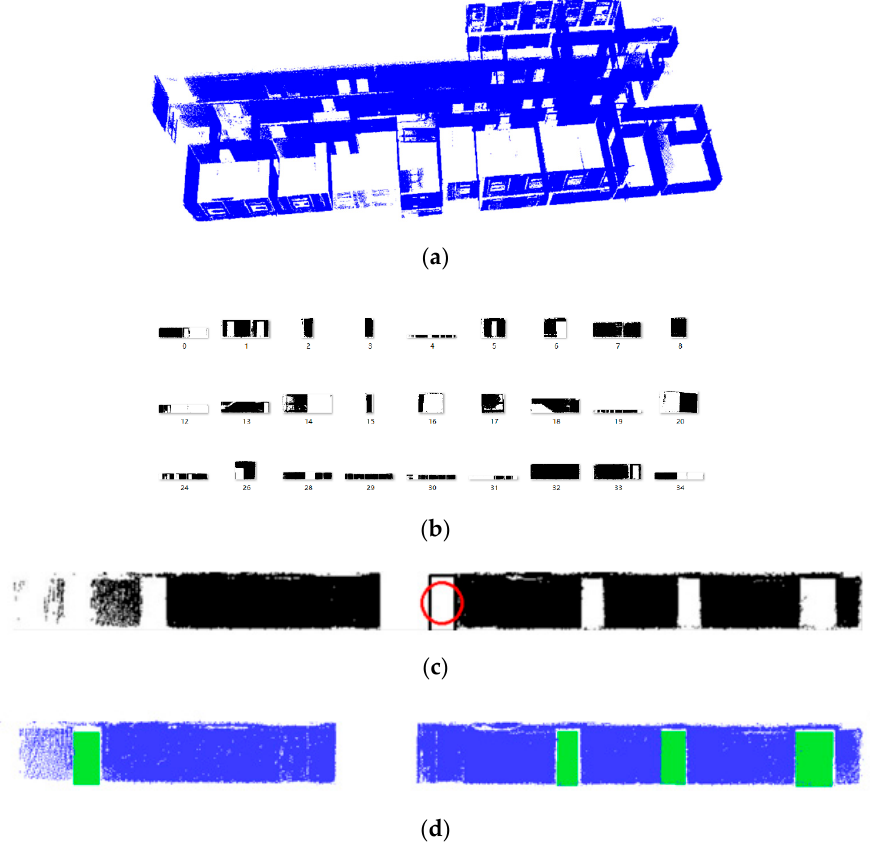
Figure 2. Detection of openings. ( a ) Extracted wall surfaces. ( b ) Wall surfaces converted into binary image. ( c ) Template match. ( d ) Detected doors.